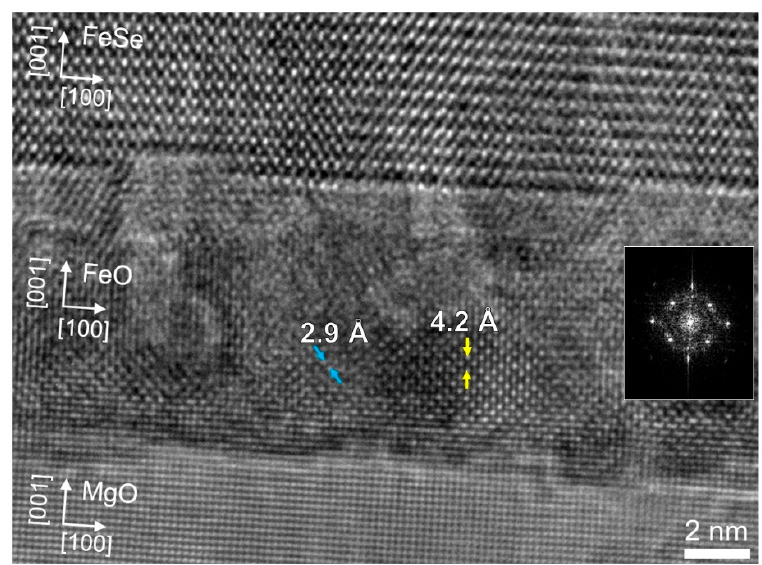
Figure 4. HR TEM image of the FeSe/Fe interface in the FeSe/Fe/MgO film (MgO annealed in UHV; T S ,FeSe = 250 ◦ C; T S ,Fe = 600 ◦ C; rep. rate = 10 Hz; t FeSe = 33 nm; t Fe = 8 nm). An epitaxial relationship with (001)[100]FeSe//(001)[100]FeO//(001)[100]MgO remained. Inset shows a diffraction pattern of FeO in the particular layer.